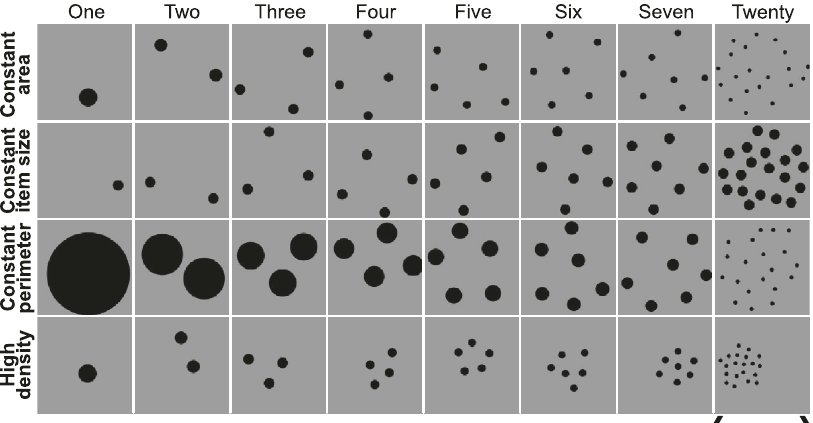
Fig. 1 Example displays from each stimulus con fi guration and numerosity. Constant area ( fi rst panel), constant size (second panel), constant perimeter (third panel), and high density (last panel). Numerosities one through seven and baseline